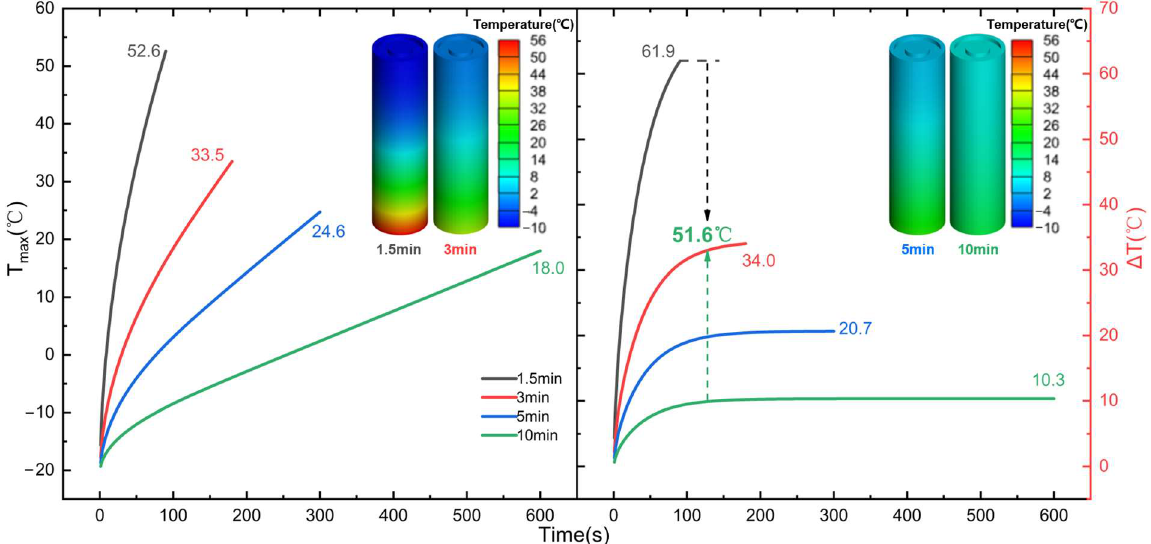
Figure 12. Temperature profile and internal temperature distribution of the cell at different heating times (heating power): Maximum temperature ( Left ); Temperature difference ( Right ).